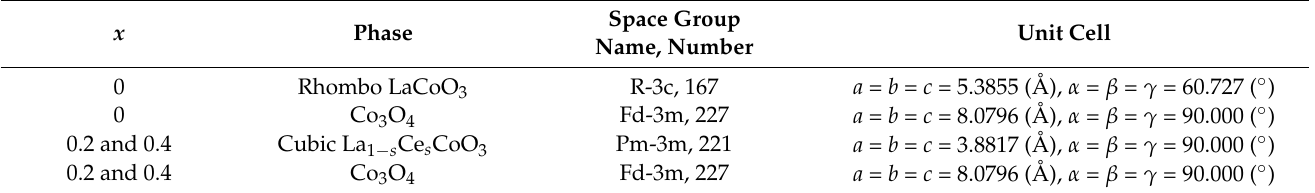
the change in distance of all paths of the main lattice and the secondary phase, respectively. Table 1. Structural information used as inputs for FEFF calculations (Rhombo =